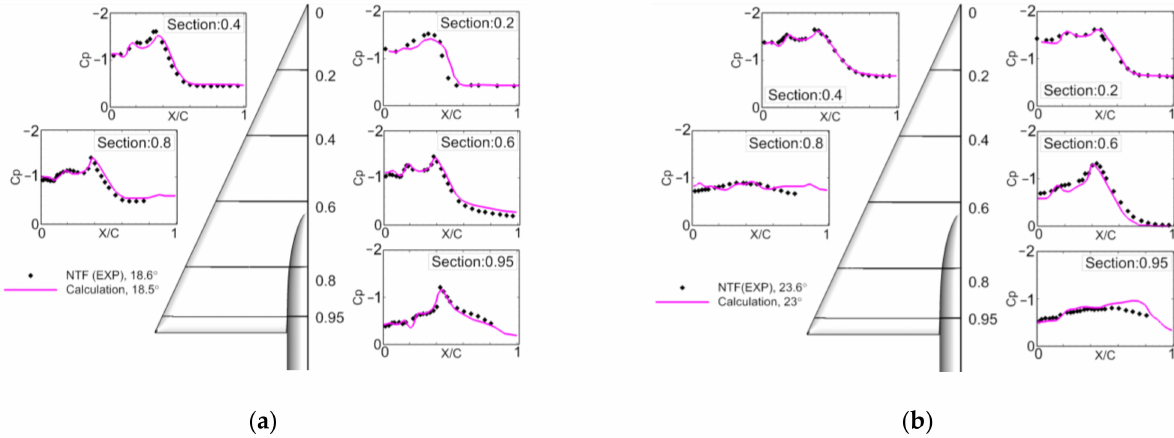
Figure 6. Pressure comparisons of the experiment [25] and CFD calculation on the upper surface of the delta wing at typical sections for Ma = 0.85, Re = 6 × 106. ( a ) α = 18.5 ◦ ; ( b ) α = 23 ◦ .